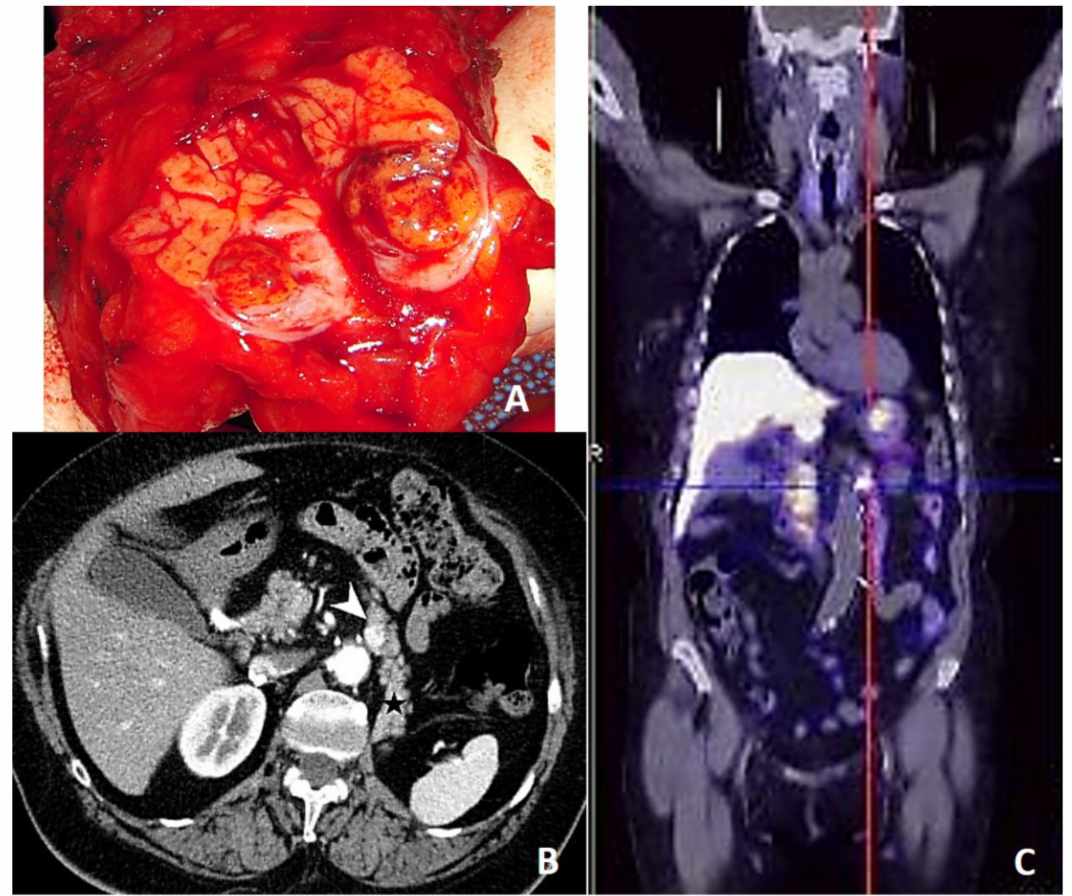
Figure 1. ( A ) Macroscopic appearance of a RCC-PM after cutting the specimen; ( B ) preoperative CT scan (white arrow for the lesion, black star for the pancreatic tail); ( C ) 68 Ga PET-CT of a single 1.2 cm-in size RCC metastasis in the pancreatic